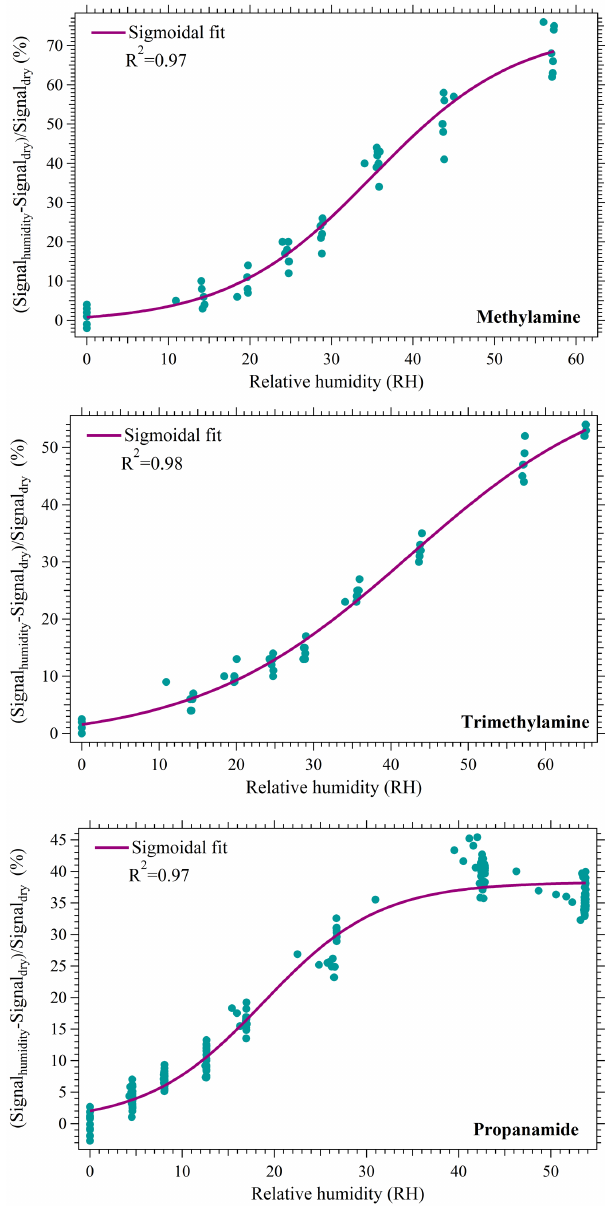
Figure 1. Influences of RH on the MS signals of methylamine (MA), trimethylamine (TMA), and propanamide